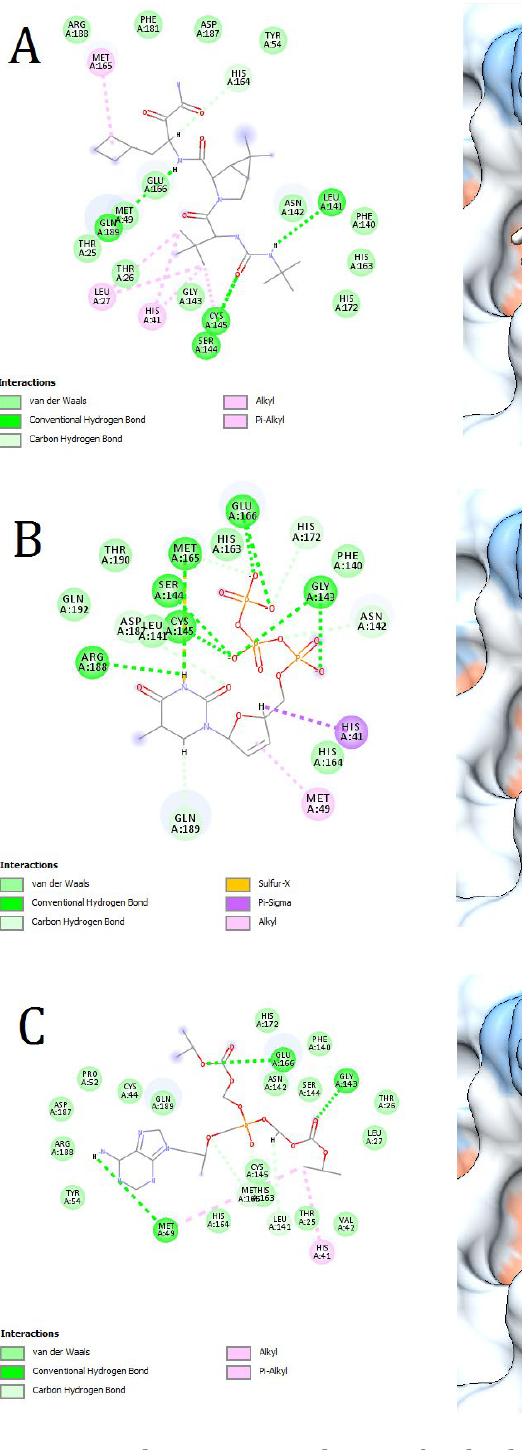
Figure 6. Docking pose visualization for the drugs with the best predicted results (Right) and their 2D receptor-ligand interaction diagram